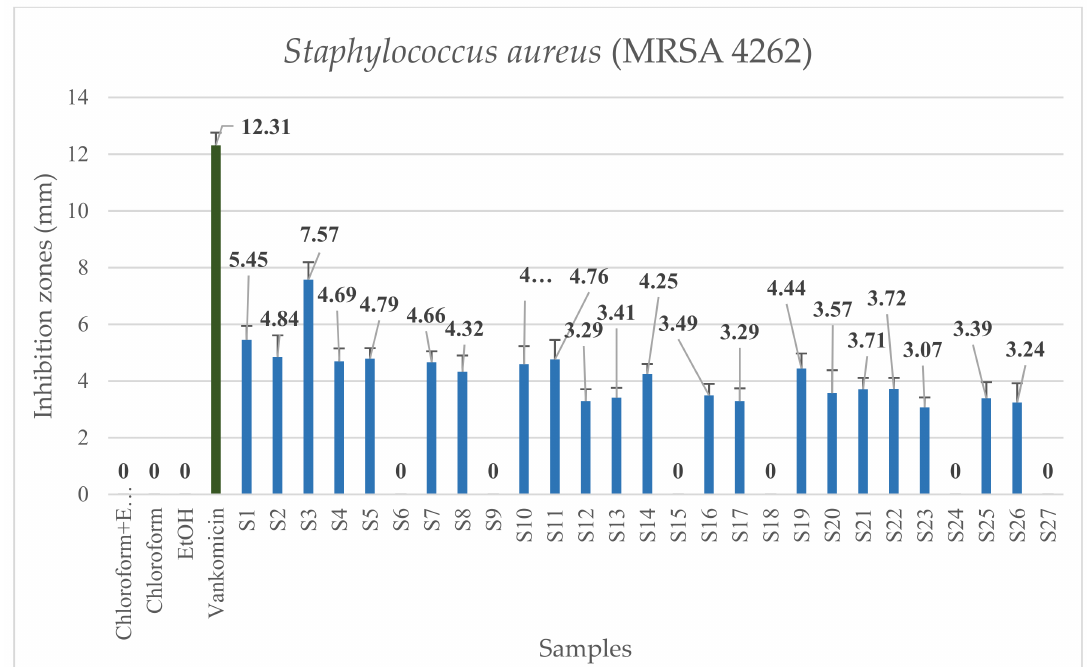
Figure 3. Antibacterial activity on MRSA of each clary sage extracts and vancomycin as positive control. The numbering of the samples is the same as that shown in Table